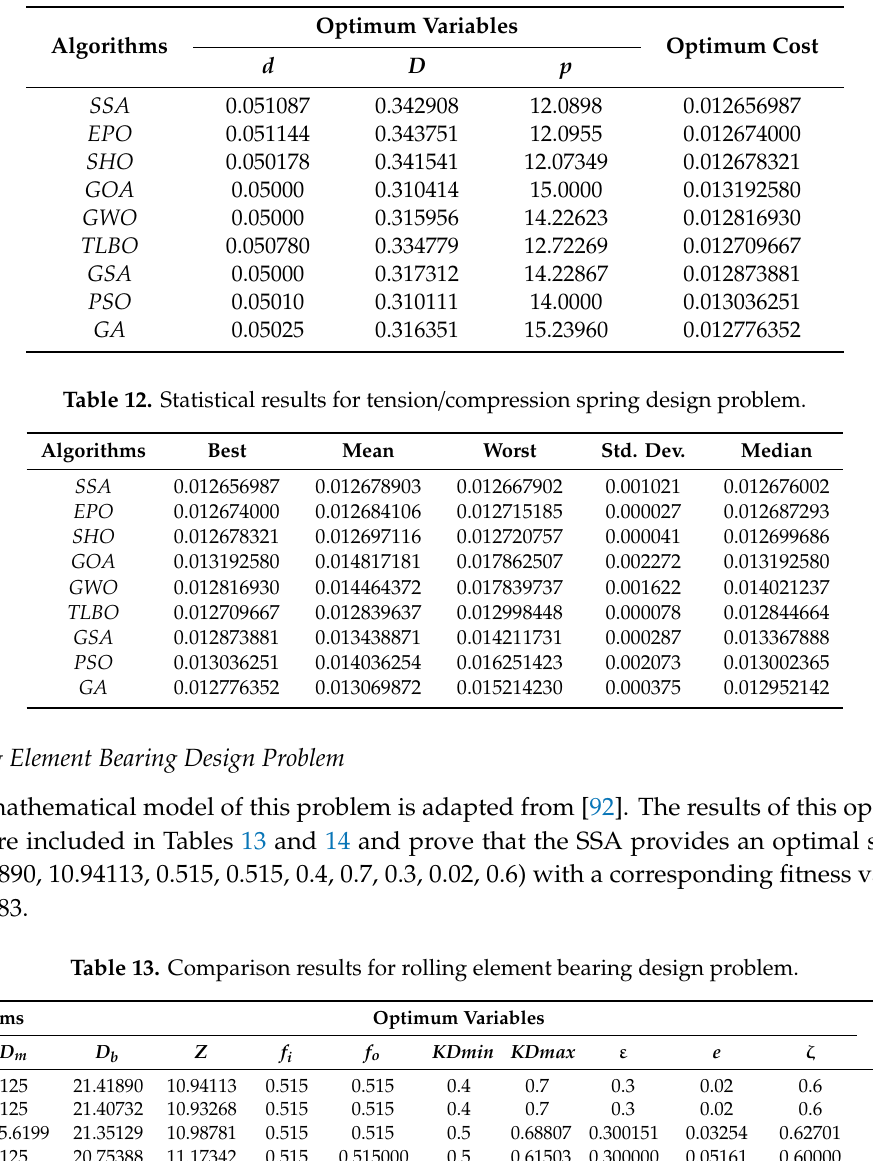
Table 11. Comparison results for tension / compression spring design problem.